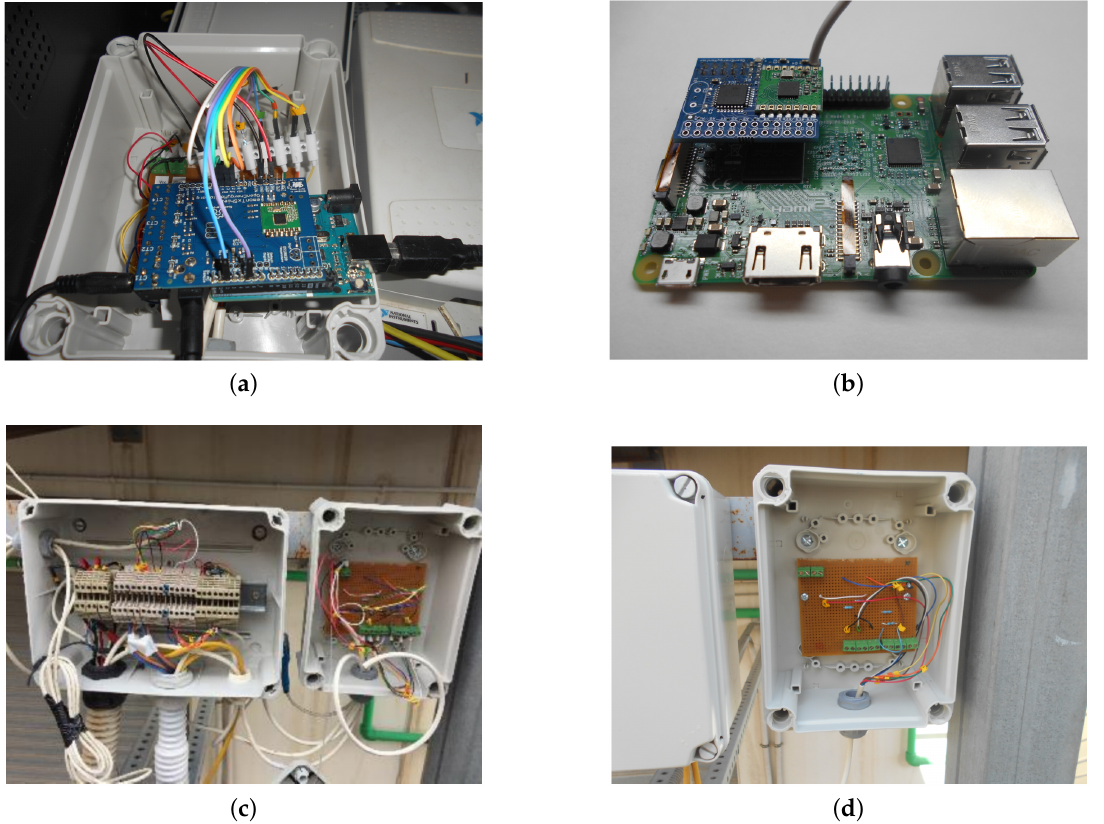
Figure 2. Examples of the prototype nodes and connections: ( a ) assembled node 1; ( b ) gateway Raspberry Pi; ( c ) external connections; and ( d ) detail of external